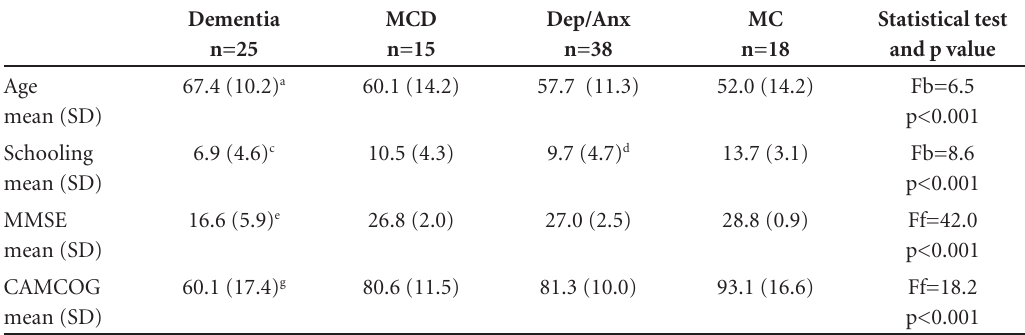
Table 3. Age, schooling, MMSE and CAMCOG scores in 4 diagnostic